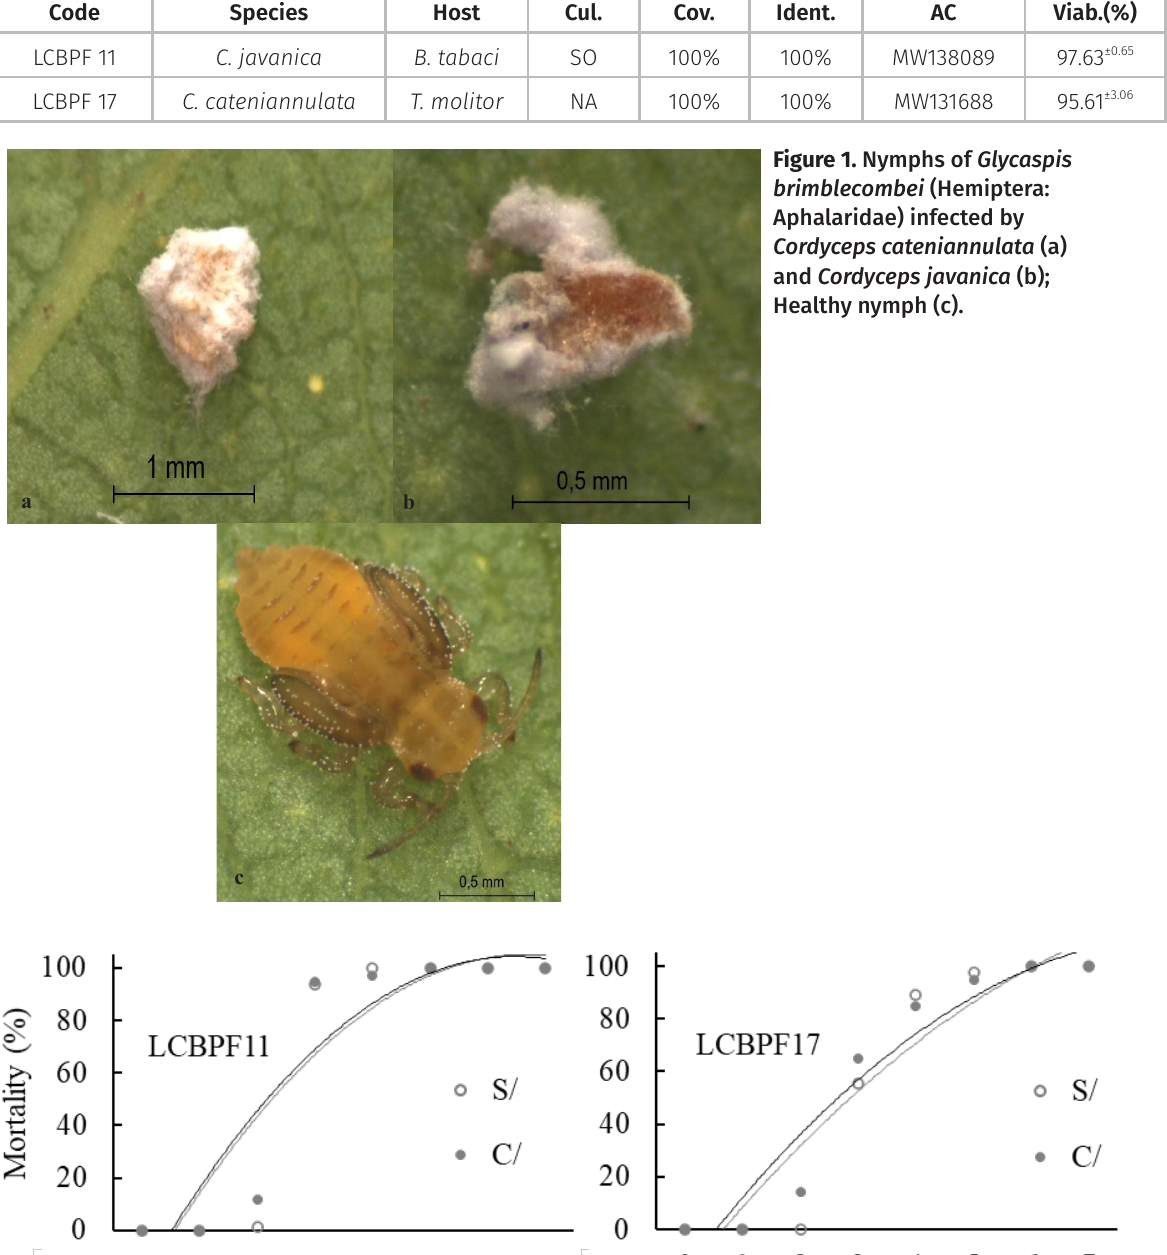
Table I. Molecular identification code (Code), species, host, culture (Cul.), coverage (Cov.), identity (Ident.), genBank access code (AC) and percentage viability (Viab.) (Mean ±SE ) of the entomopathogenic fungi Cordyceps javanica isolates collected in soybean (SO) and Cordyceps cateniannulata in native forest (NA) in Botucatu, São Paulo, Brazil.